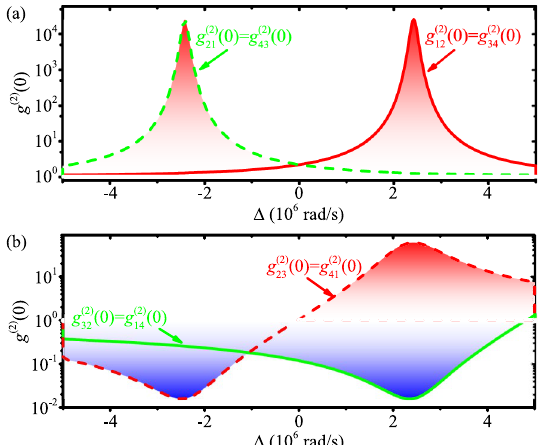
Figure 2. (Color online) The equal-time second-order correlation function of the port-to-port transmission photons versus the detuning (cid:31)